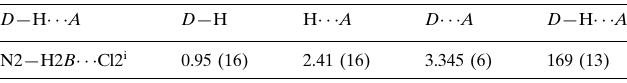
Hydrogen-bond geometry (A˚ , (cid:2)